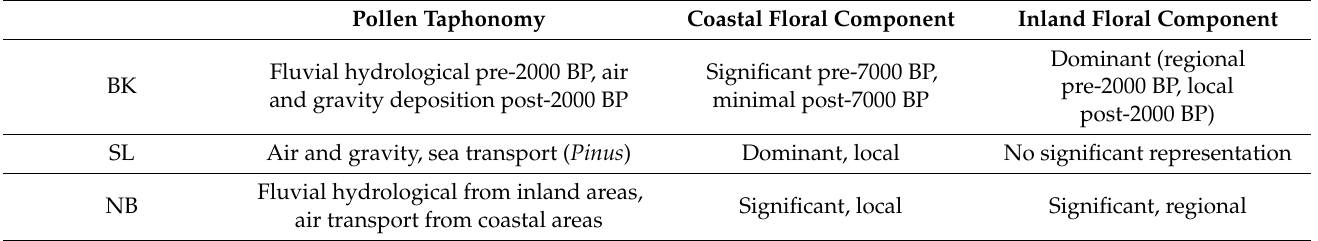
Table 6. Inferred taphonomic characteristics of pollen sites (BK, SL and